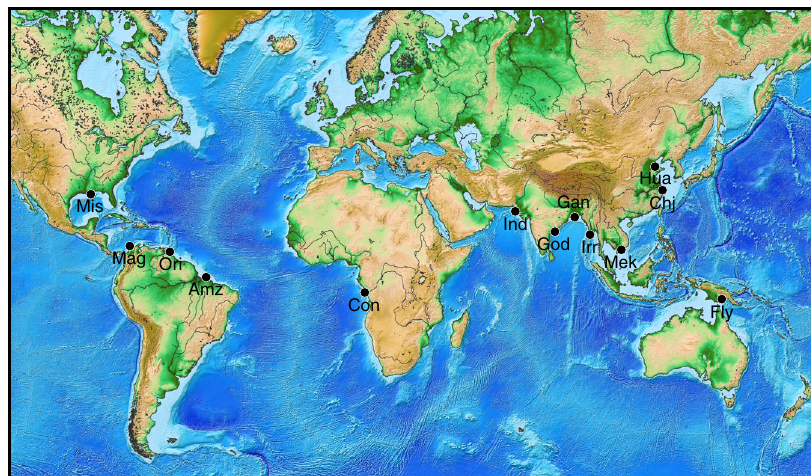
Fig. 1 Rivers which sediment discharge is estimated in this work. Gan: Ganges-Brahmaputra, Irr: Irrawaddy, Amz: Amazon, Chj: Changjiang, Ind: Indus, Mag: Magdalena, God: Godavari, Mek: Mekong, Con: Congo, Hua: Huanghe, Mis: Mississippi, Ori: Orinoco. Figure 1 created using GMT software